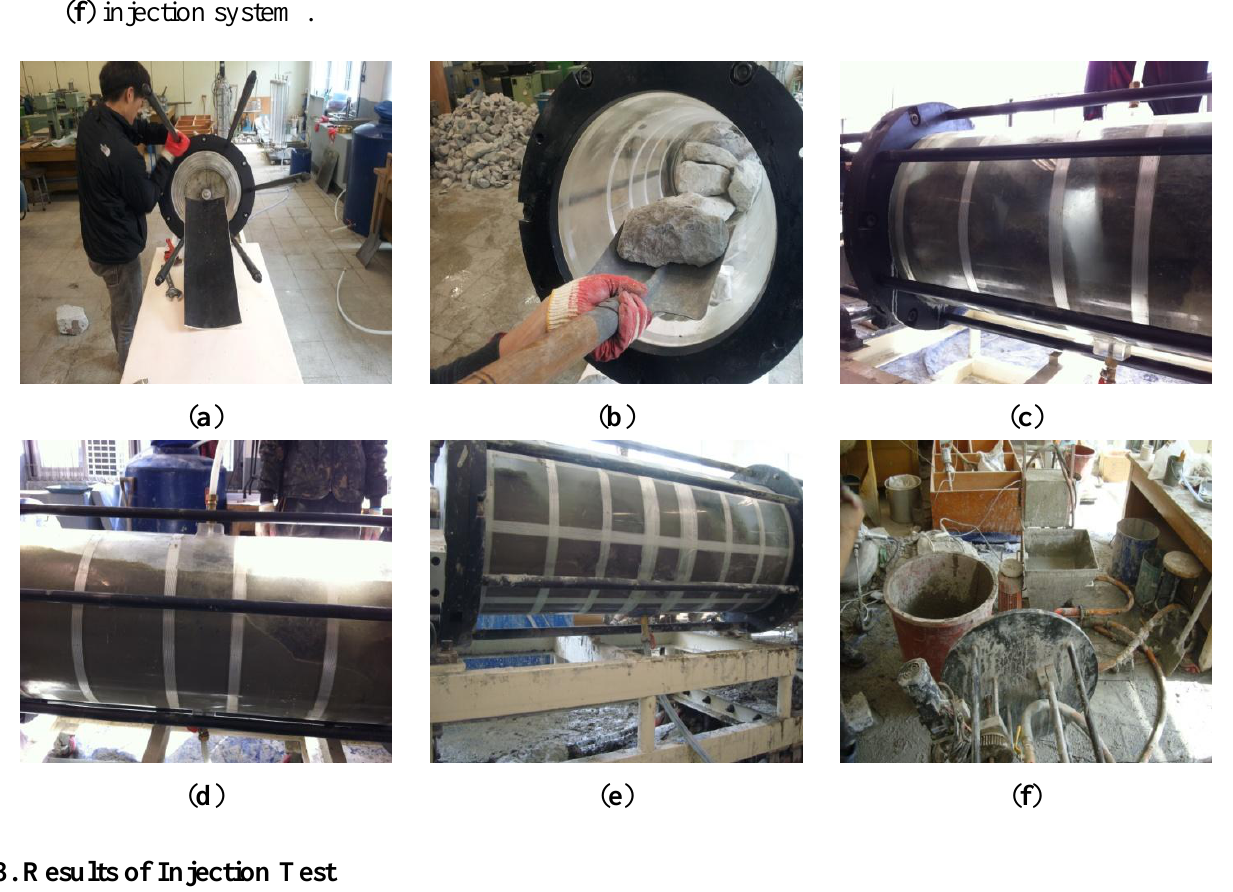
Figure 4. Process of grouting. ( a ) assemble the system; ( b ) fill the system with riprap; ( c ) saturated riprap layer; ( d ) inject mixed grout; ( e ) speed of moving fluid; ( f ) injection system